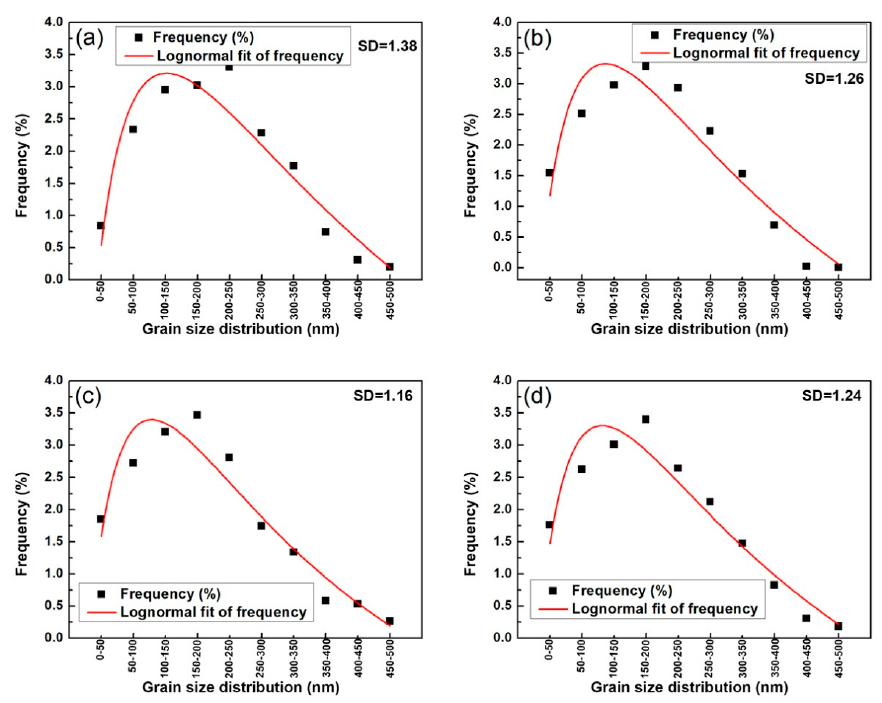
Figure 9. Distributions of ferrite size at different reductions ( a ) 50%, ( b ) 60%, ( c ) 70%, and ( d ) 80%.